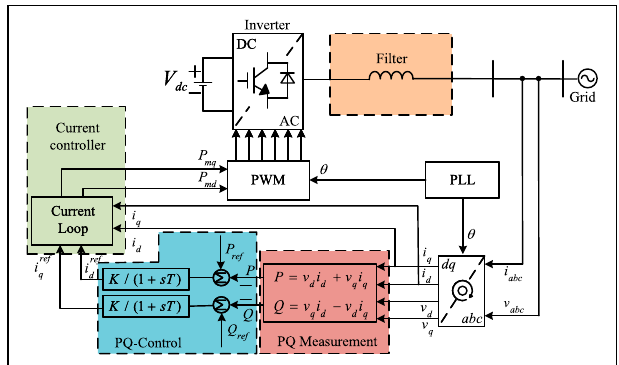
FIGURE 1 | Control strategy diagram of PQ-control.